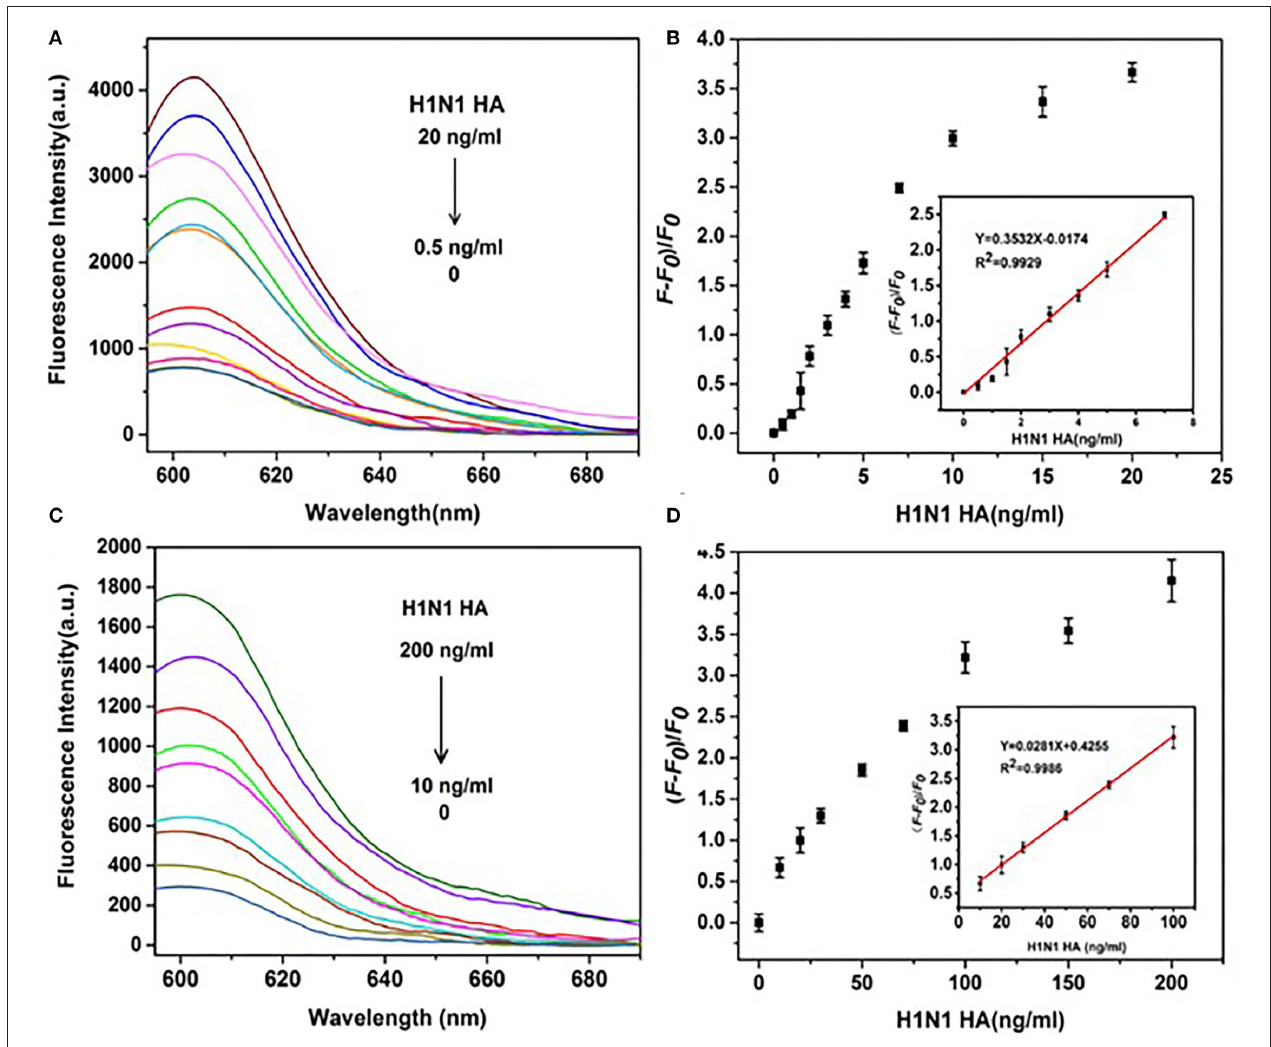
FIGURE 8 | Effects of DNase I on the sensitivity of detection of H1N1 HA. (A) Fluorescence spectra of a series of concentrations of H5N1 HA (0, 0.5, 1, 1.5, 2, 3, 4, 5, 7, 10, 15, and 20ng/ml) in the presence of DNase I. (B) (F – F0)/F0 (fluorescence change) vs. concentration of H1N1 HA in the presence of DNase I. (C) Fluorescence intensities of a series of concentrations of H1N1 HA (0, 10, 20, 30, 50, 70, 100, 120, 150, and 200ng/ml) in the absence of DNase I. (D) (F – F0)/F0 (fluorescence change) vs. concentration of H1N1 HA in the absence of DNase I. The insets depict a linear relationship between (F – F0)/F0 and the concentration of HA H1N1 in the presence of DNase I (B) and the absence of DNase I (D)